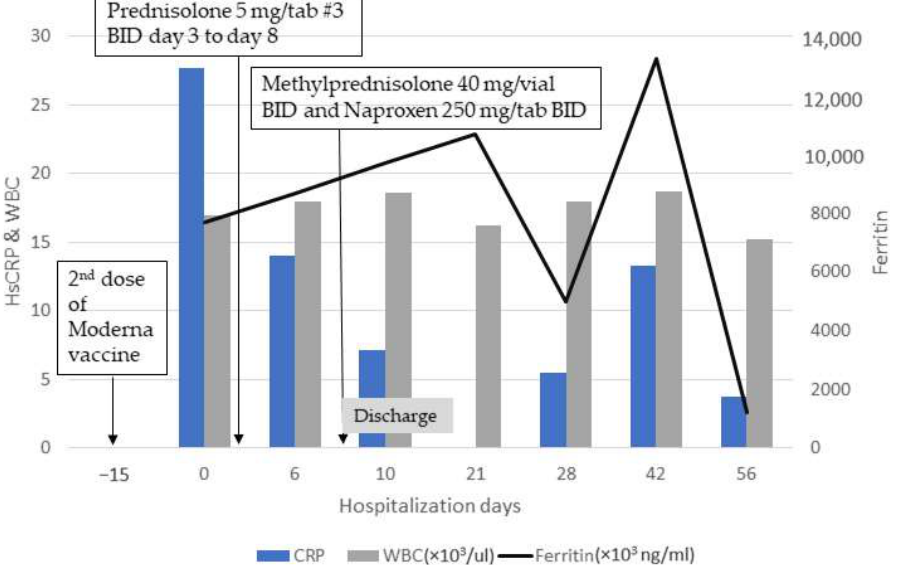
Figure 2. Clinical course and treatment of patient who received the Moderna COVID-19 vaccine. This patient had been suffering from general weakness, sore throat, and generalized skin rashes without an itch followed by a persistent fever of up to 40 ◦ C with chills approximately two weeks after her second dose of the Moderna COVID-19 vaccine. Prednisolone 15 mg twice daily was administered, but improvement was limited. Her clinical condition improved significantly, and HsCRP decreased steadily after we switched her medication to methylprednisolone 40 mg intravenously twice a day and naproxen 250 mg twice a day. Hs-CRP, high-sensitivity C-reactive protein; WBC, white blood